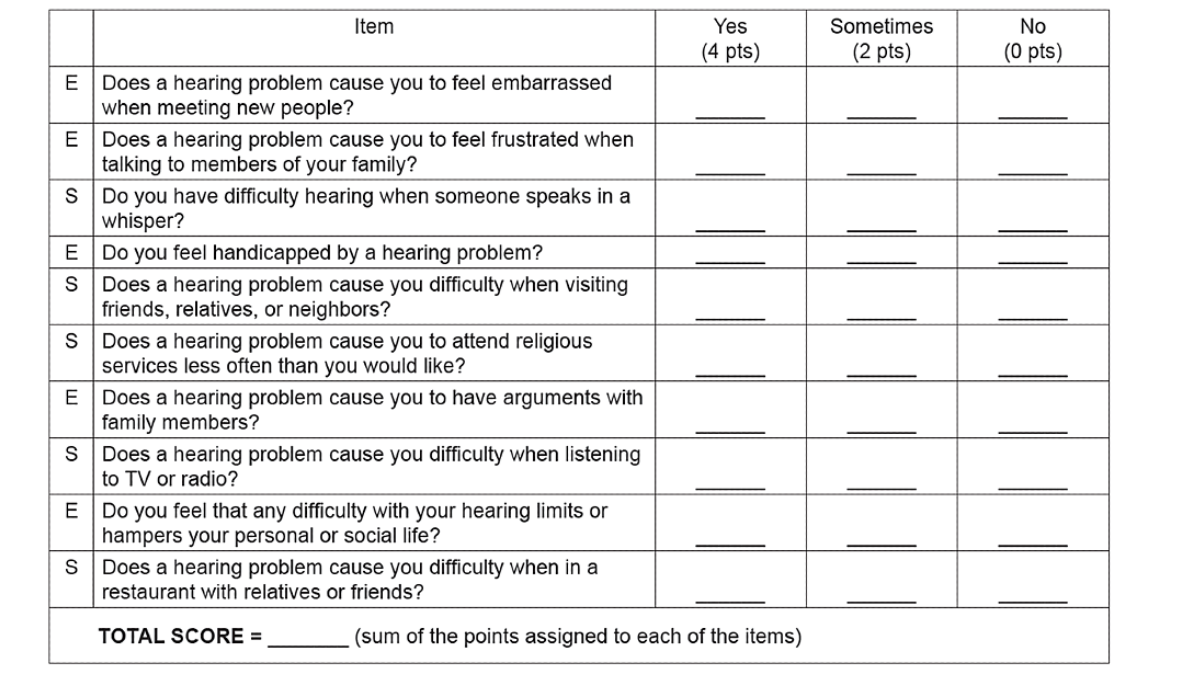
Figure 1. Hearing Handicap Inventory for the Elderly Screening